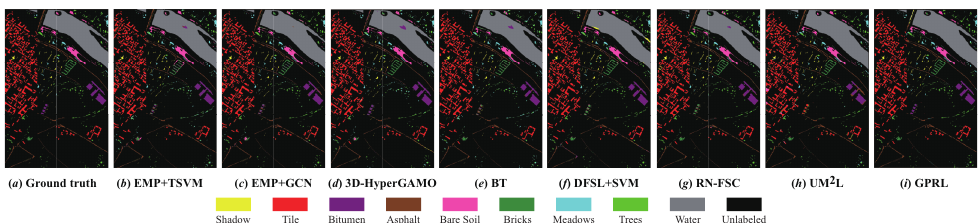
Figure 7. The classification maps of different methods on the PC data set.